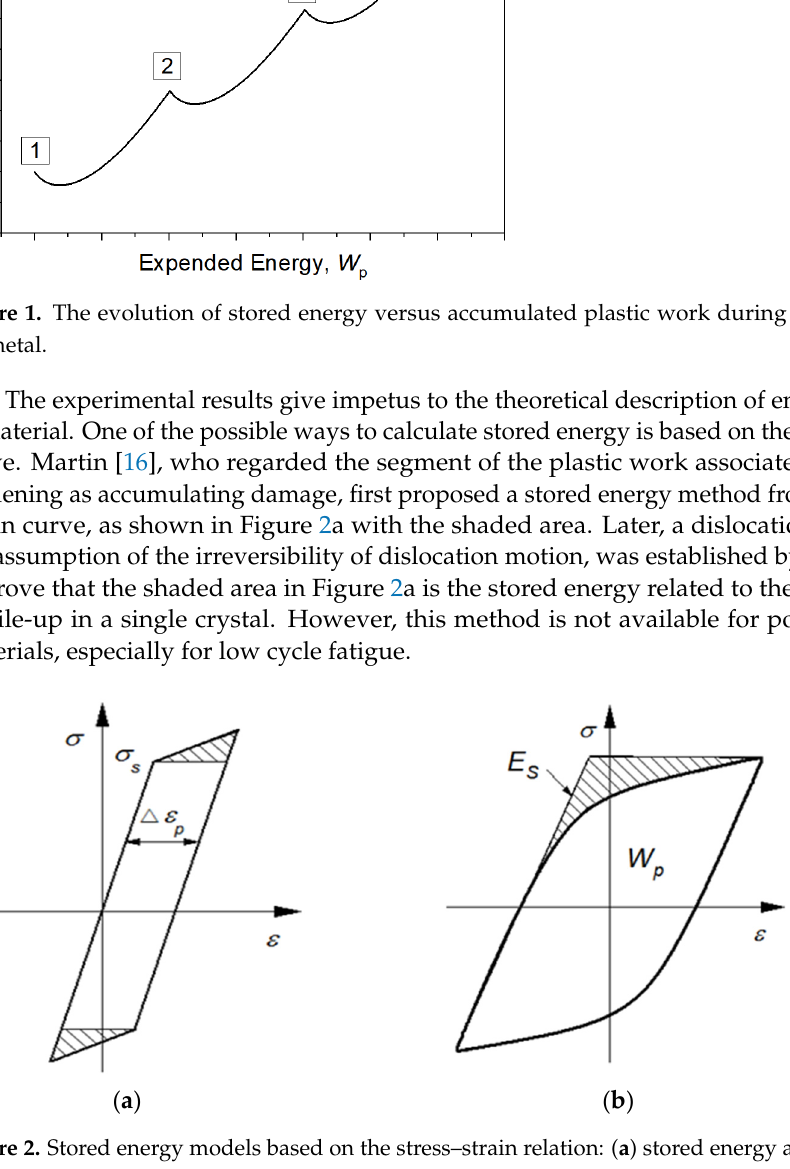
Figure 1. The evolution of stored energy versus accumulated plastic work during cyclic loading for metal.